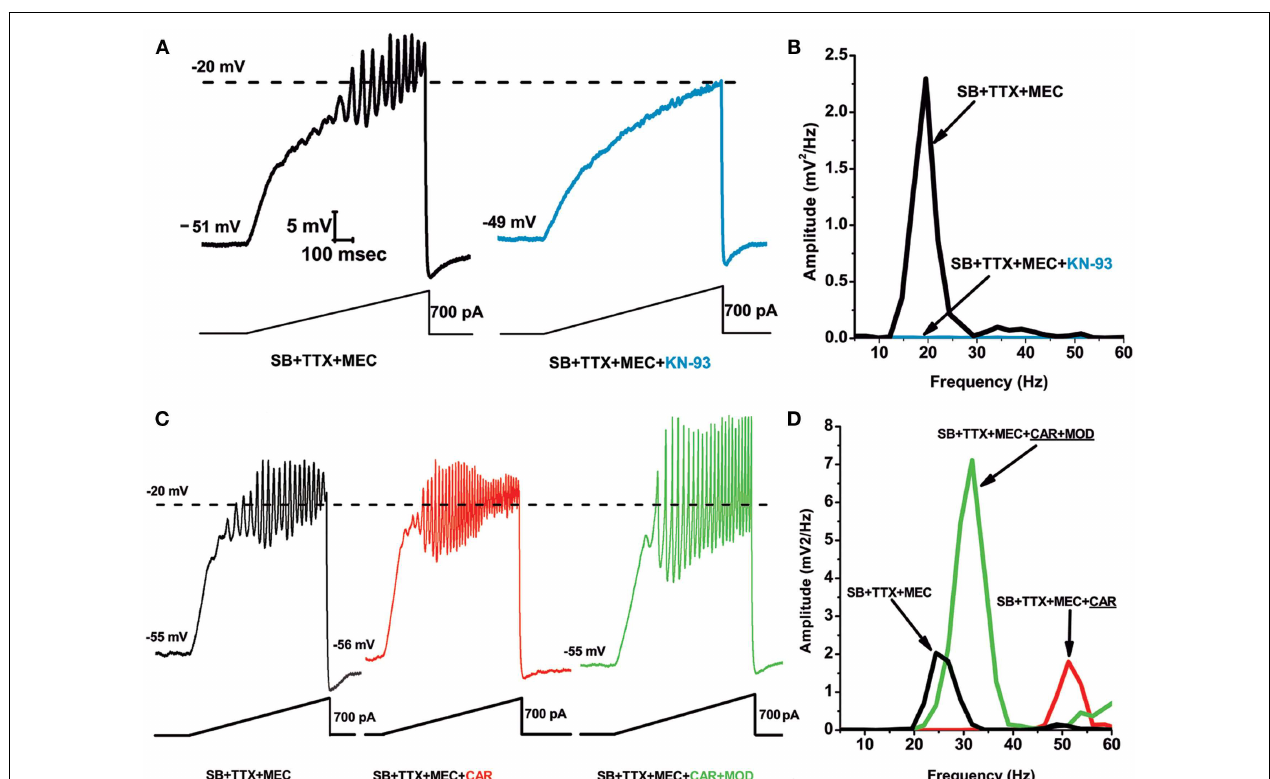
administration of CAR (30 µ M) (black record), 20min after continuous superfusion with CAR (red record), and 20min after continuous superfusion with MOD and CAR (green record). (D) Power spectrum before CAR (black line, beta range), after CAR (red line, gamma range), and after CAR + MOD (green line, beat/gamma range).These results suggest that the stimulant MOD, which requires the CaMKII pathway, potentiates responses to cholinergic input to the PPN